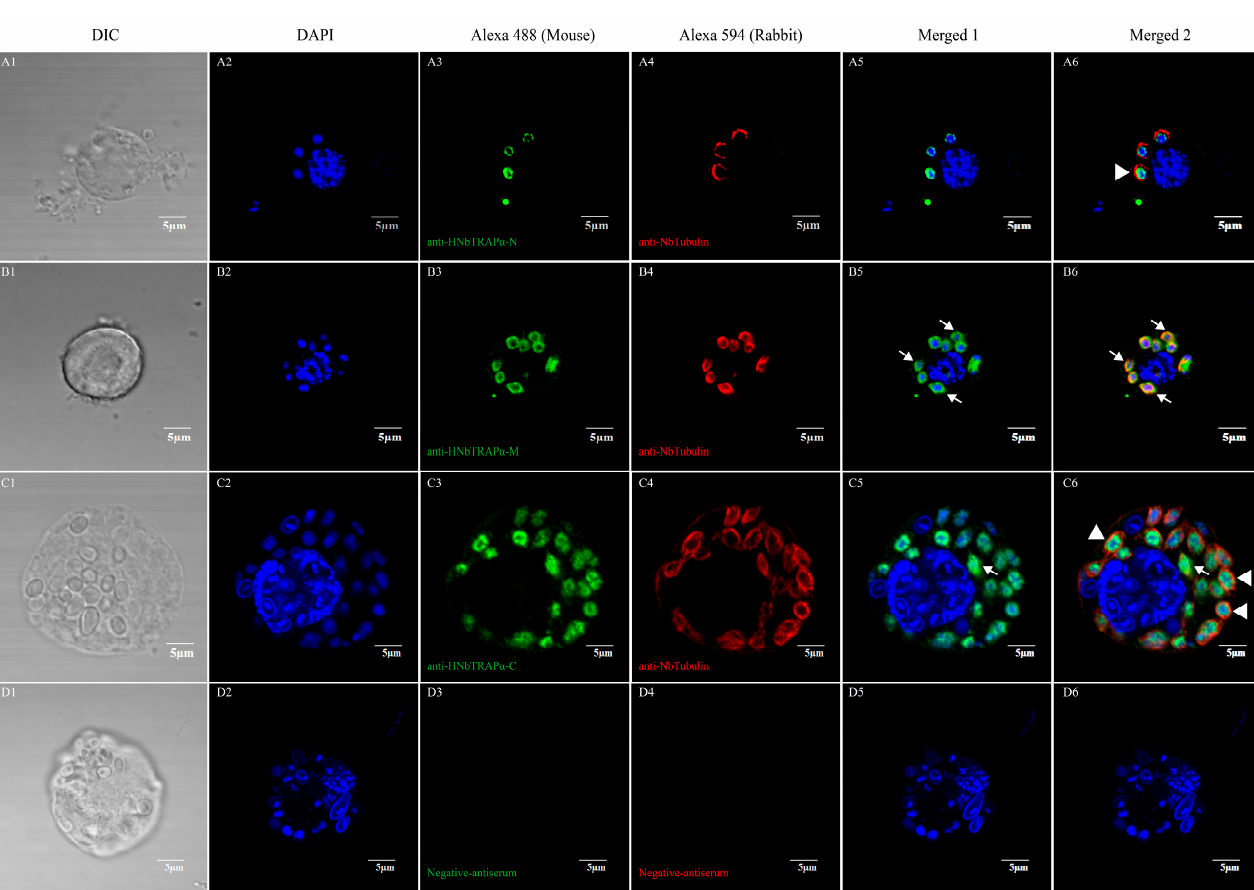
8 of 12 Figure 3. Western blo tt ing assay of HNbTRAP α in N. bombycis mature spores and infected Sf9 cells that predominantly with the proliferative phase of N. bombycis . ( A ): The protein isoform detection of HNbTRAP α in mature spores and proliferative stage with anti-HNbTRAP α -C serum. The anti- serum against HNbTRAP α -C can bind strongly with a ~37 kDa band and weakly with a ~86 kDa band in puri fi ed mature spores. While, this antiserum speci fi cally recognized a ~45 kDa protein in Sf9 cells with N. bombycis infection. ( B ): The antiserum against HNbTRAP α -C strongly bound with the ~45 kDa protein and two weak protein bands in infected Sf9 cells under overexposure condi- tions. The protein ~37 kDa, ~45 kDa, and ~86 kDa are consistent with the predicted weight of the isoform that polyadenylated at 951 bp, 1167 bp and the full length of HNbTRAP α . M: Marker; Nb: Nb mature spores; Nb-Sf9: Nb infected Sf9 cells. 3.4. HNbTRAP α Localized at the Perinuclear Region or in the Nucleus during Di ff erent Development Stages To test whether HNbTRAP α could transport into the nucleus as a bioinformation prediction, we detected the location characteristic of HNbTRAP α at di ff erent develop- ment phases through an indirect immuno fl uorescent assay. The polyclonal antisera of the N terminal (1–232 aa), central region (233–327 aa), and C terminal (569–742 aa) of HNbTRAP α were prepared. The antiserum against Nbtubulin- β of N. bombycis was used